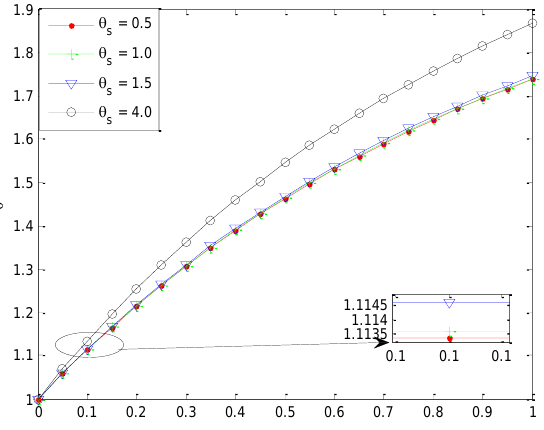
Fig. 6. Effect of surrounding temperature on the temperature profile